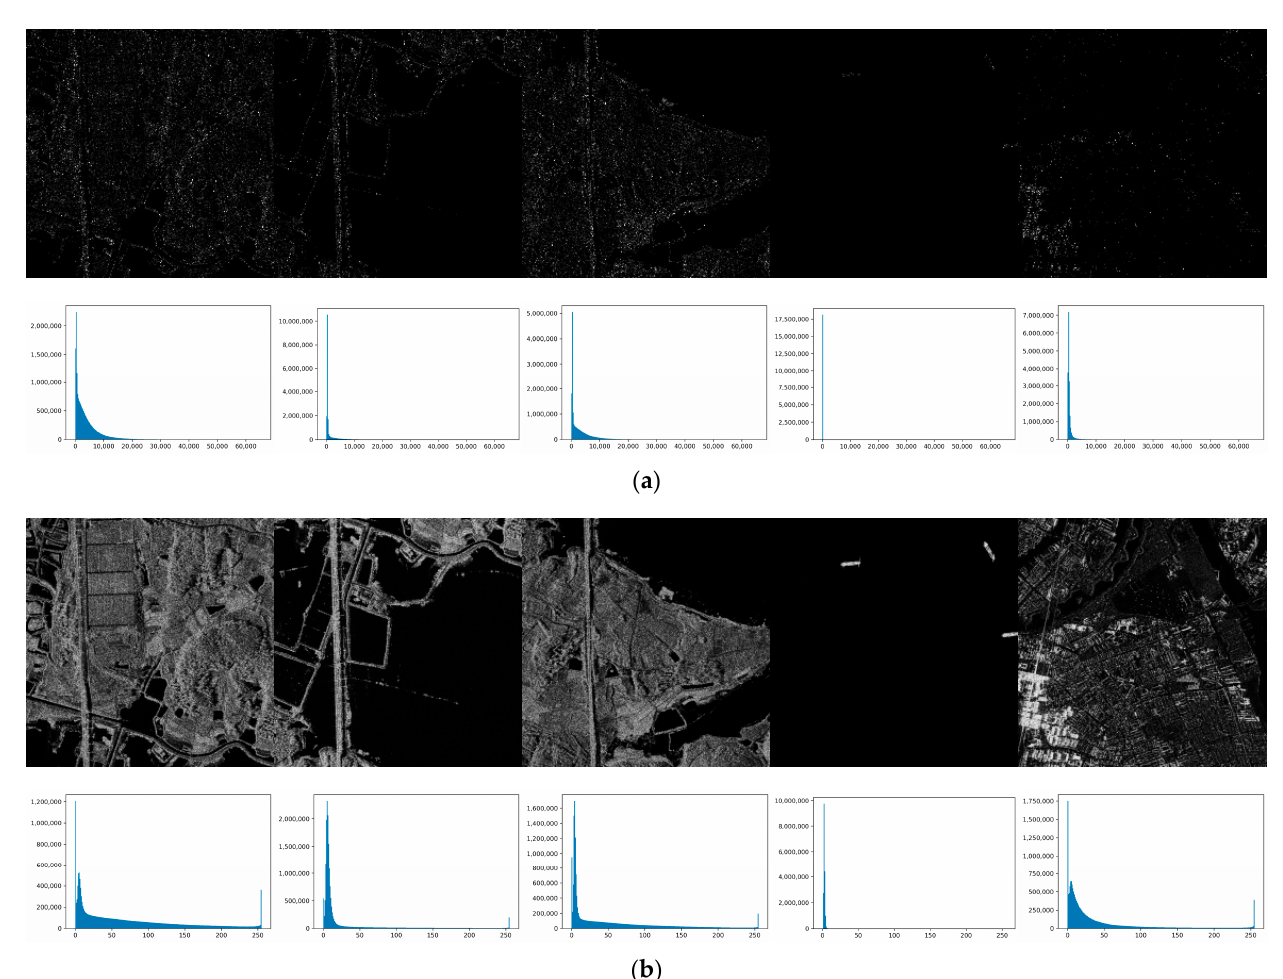
Figure 6. Examples of synthesized SAR image slices. The histogram exhibits the pixel distribution in the image. ( a ) Original SAR images to be visualized. ( b ) Corresponding ground truth.